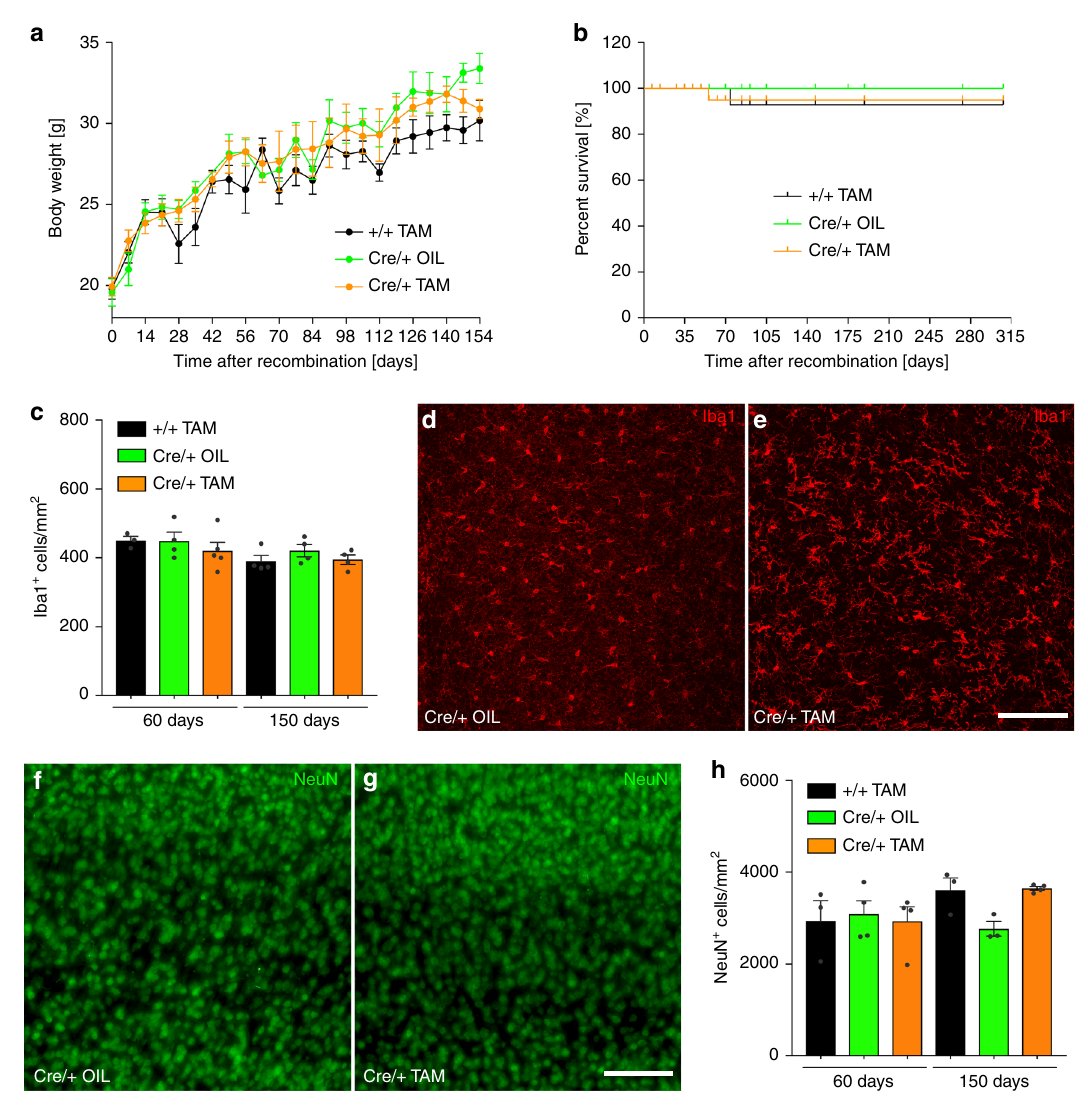
Fig. 2 Normal mouse survival and no impairment of microglia maintenance after microglia-speci fi c knockout of Tgfbr2. a Body weight increase after TAM- induced recombination at 6 − 8 weeks of age (timepoint 0). Weights were measured weekly in control ( + / + TAM, Cre/ + OIL) and knockout (Cre/ + TAM) animals. Data points indicate mean ± SEM ( n = 3 – 18 mice). b Kaplan − Meier survival curves of control and knockout mice after